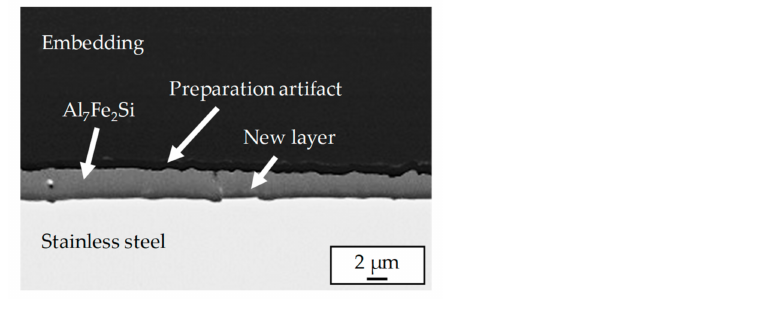
Figure 6. Cross section of the fracture surface of the sample aged at 500 ◦ C for 6 h after the tensile shear test.